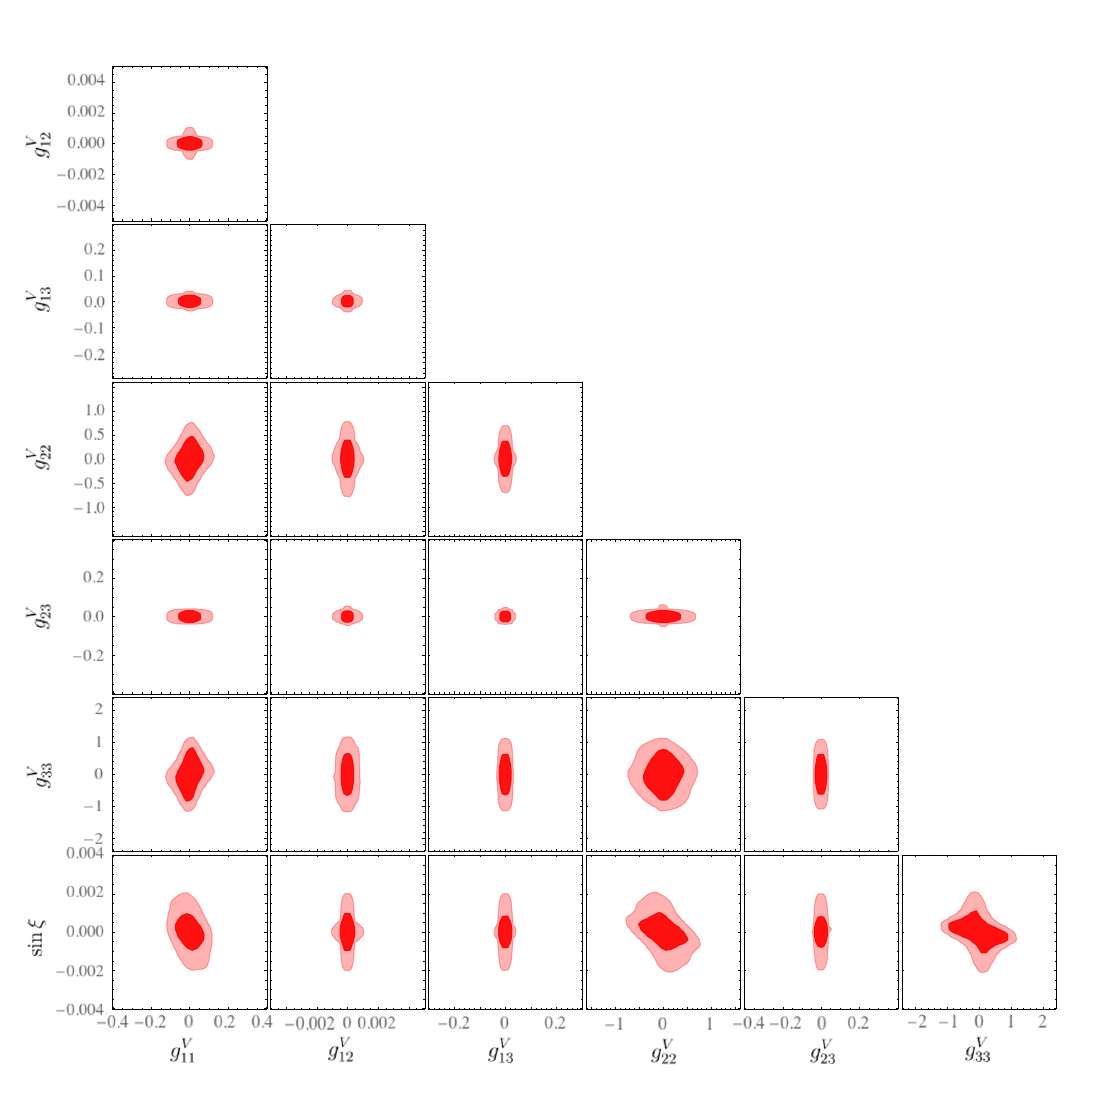
= g L = g R and sin ξ ij ij ij